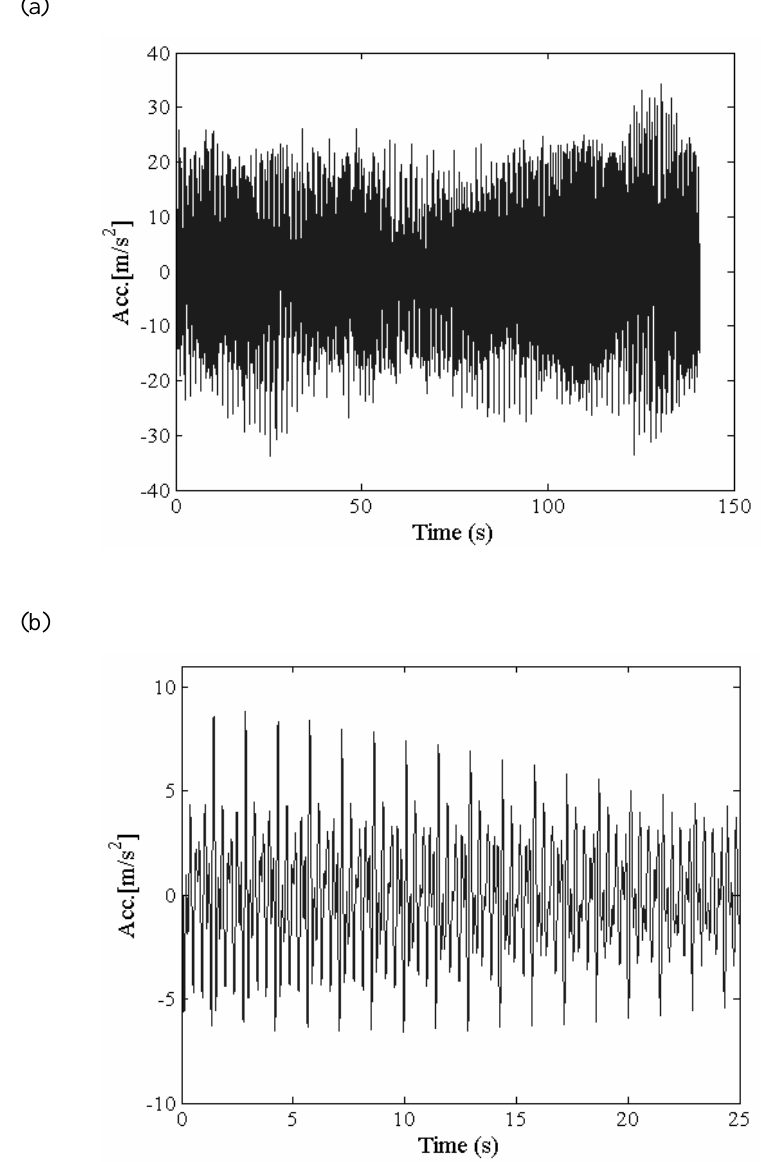
Fig. 6. (a) Ambient response; (b) Free response from the random decrement